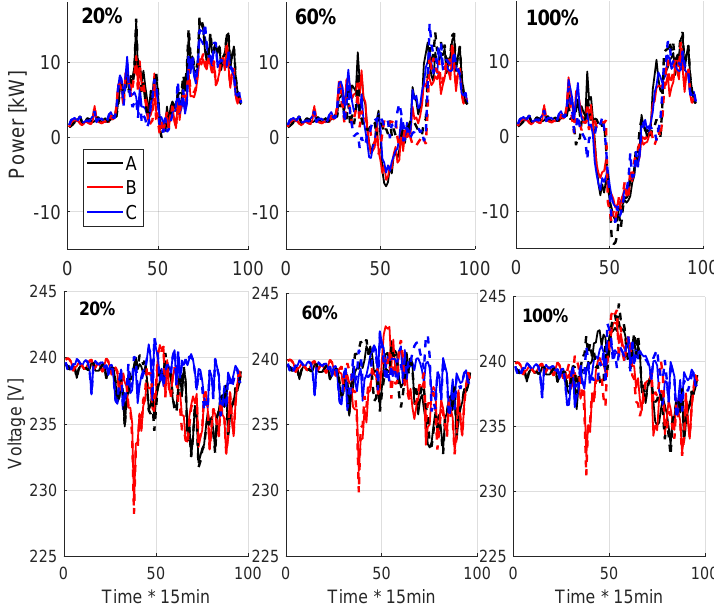
Figure 11. Power on Transformer LV Side and Voltages on the furthest node from the transformer for different PV penetration percentages (full − net-metering; dashed − market). Values are depicted in time in 15-min increments.